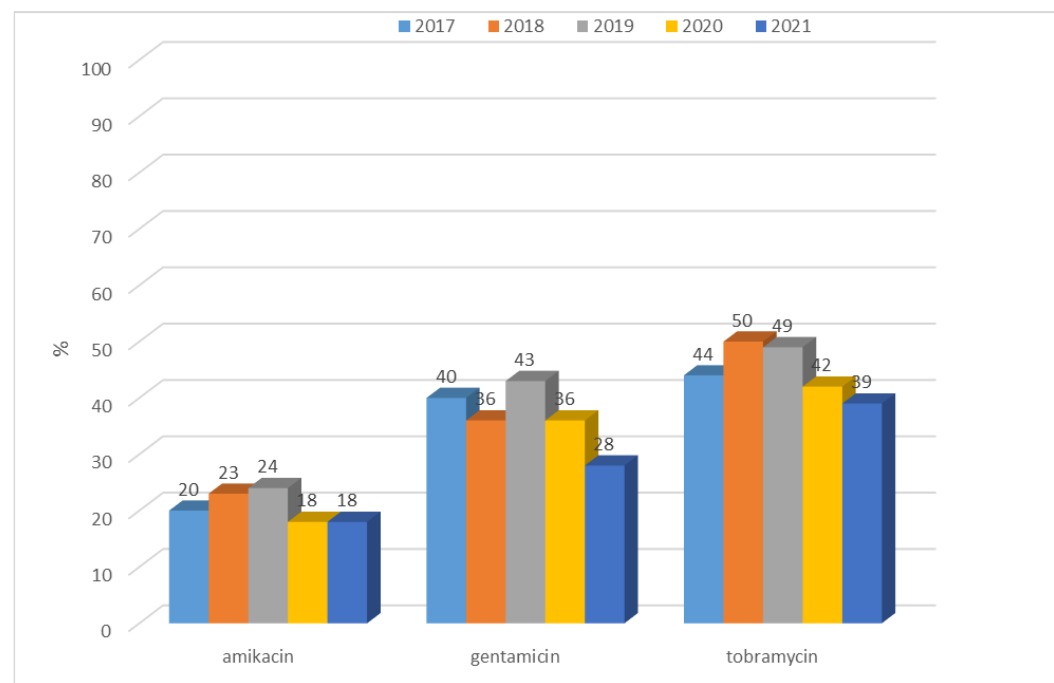
Figure 8. Percentage of E. coli ESBL(+) strains resistant to aminoglycosides.